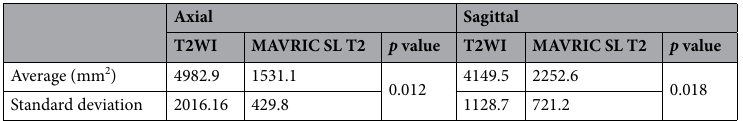
Table 1. The areas of signal voids of MAVRIC SL T2 in both the axial and sagittal planes.